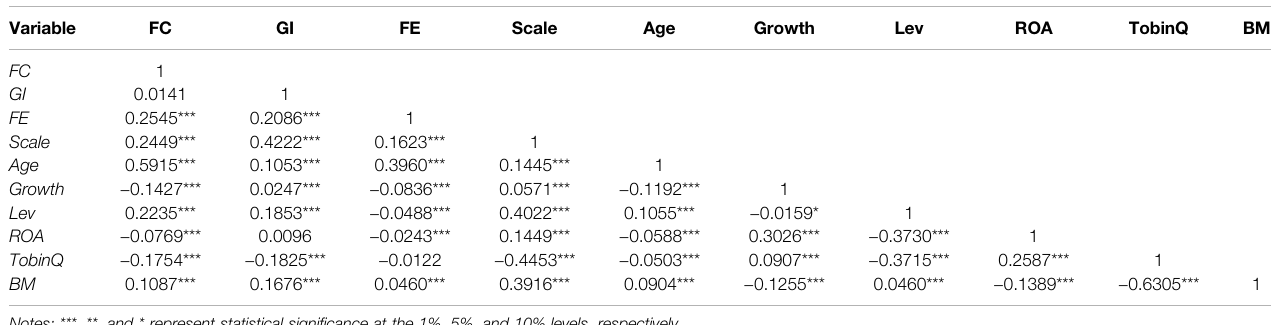
TABLE 5 | Correlation analysis.